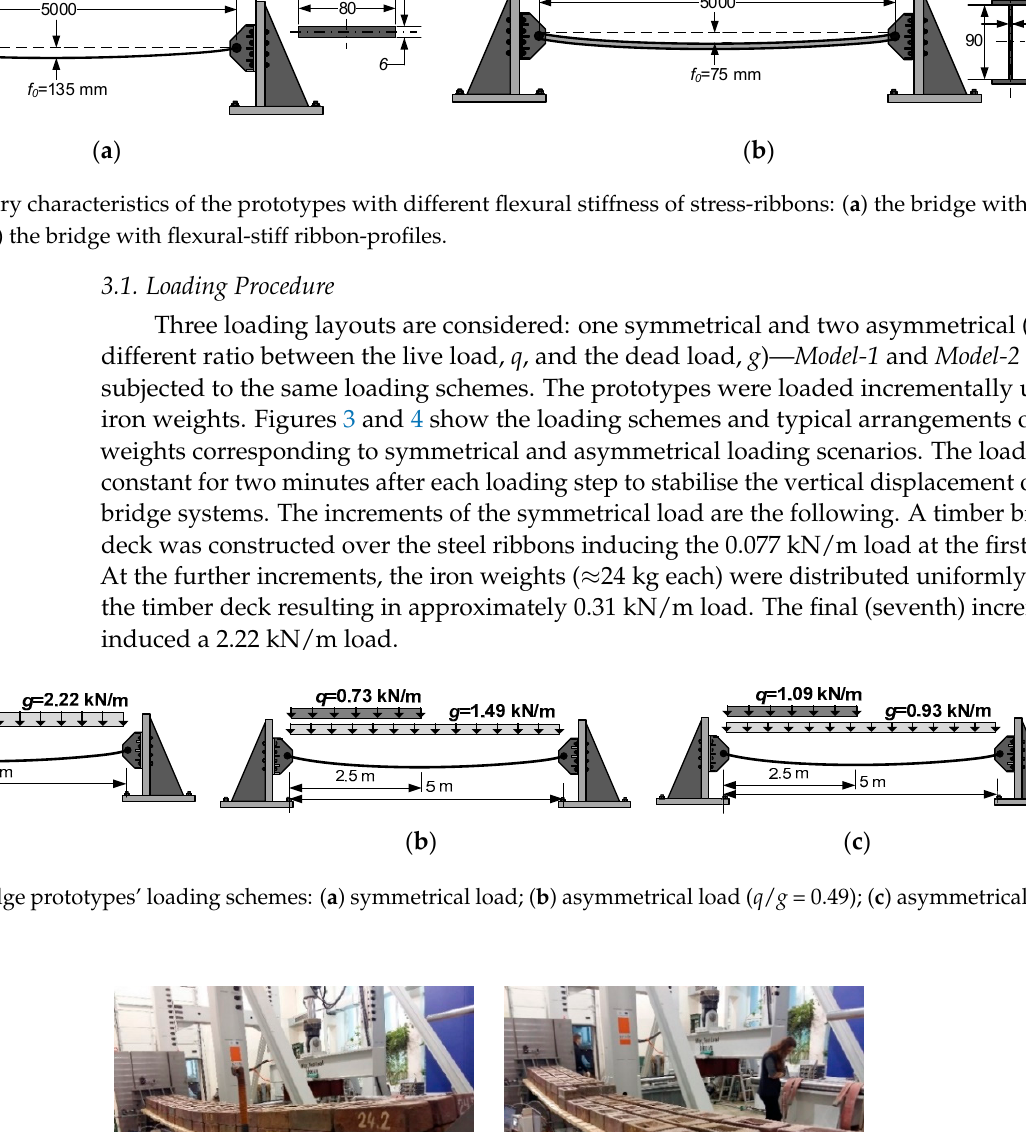
Figure 3. The bridge prototypes’ loading schemes: ( a ) symmetrical load; ( b ) asymmetrical load ( q / g = 0.49); ( c ) asymmet- rical load ( q / g = 1.17).